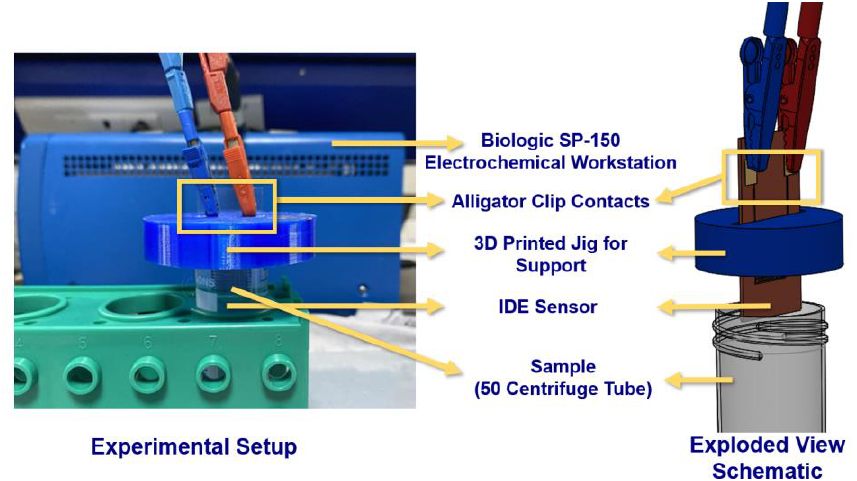
Figure 3. Experimental setup and schematic showing the enhanced view of the experimental setup for EIS analysis using potentiostat. A two-electrode configuration was employed with a frequency ranging from 1 Hz to 1 MHz.